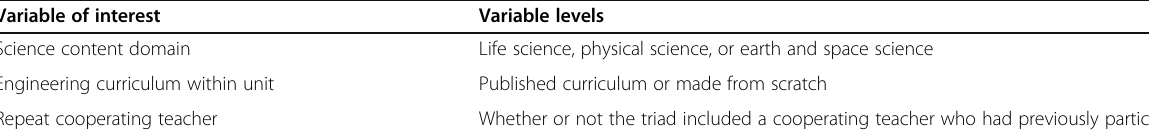
Table 4 Summary of variables used for research question 3 Variable of